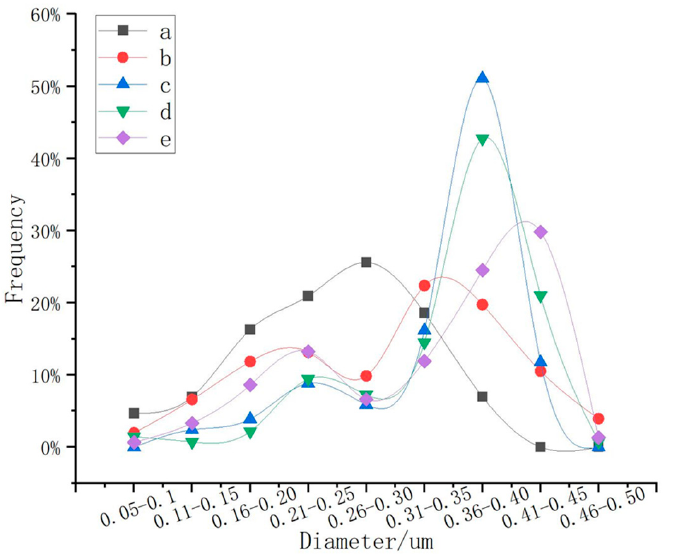
Figure 8. Particle size distribution curves of 150 microspheres. Solvent amounts: (a) 40 mL EG; (b) 50 mL EG; (c) 60 mL EG; (d) 70 mL EG; and (e) 80 mL EG.